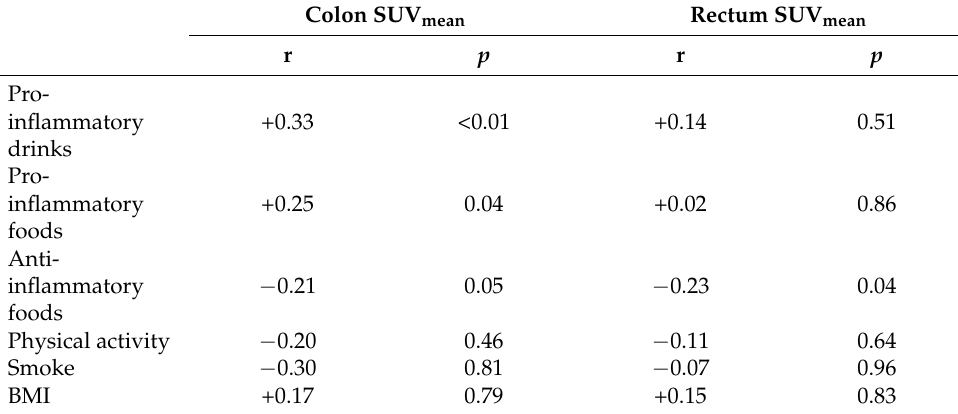
Table 5. Pearson’s correlation (r) e relative p -values ( p ) between bowel [18]F-FDG uptake and patients’